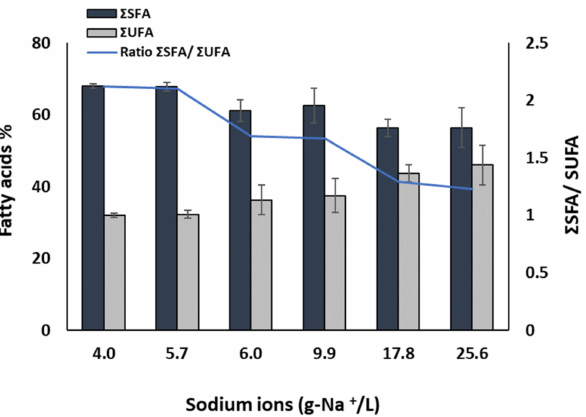
Figure 4. Total saturated ( Σ SFA) and unsaturated ( Σ UFA) fatty acids and their ratios in A. platensis grown at different salinities. ( n = 3, ± SD).